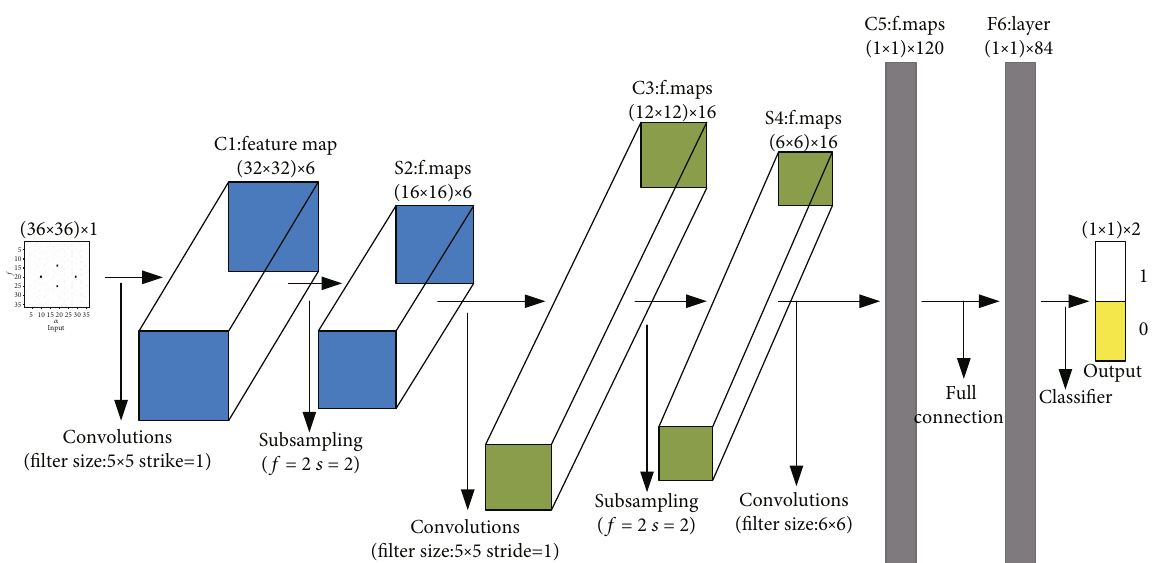
Figure 7: Improved structural model of CNN.